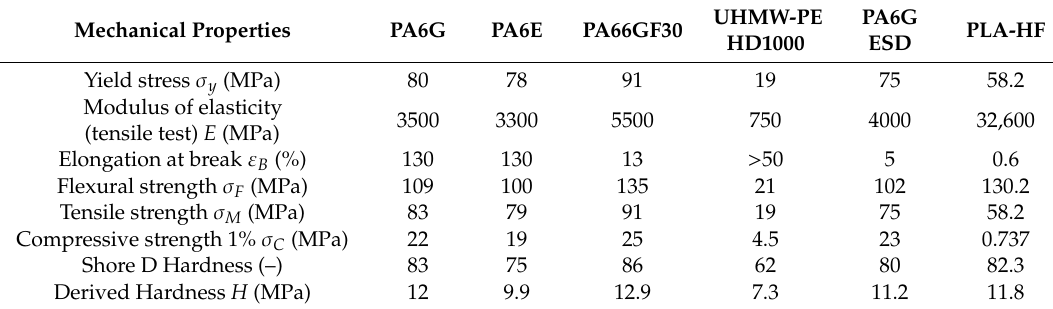
Table 3. Mechanical properties of the used composite